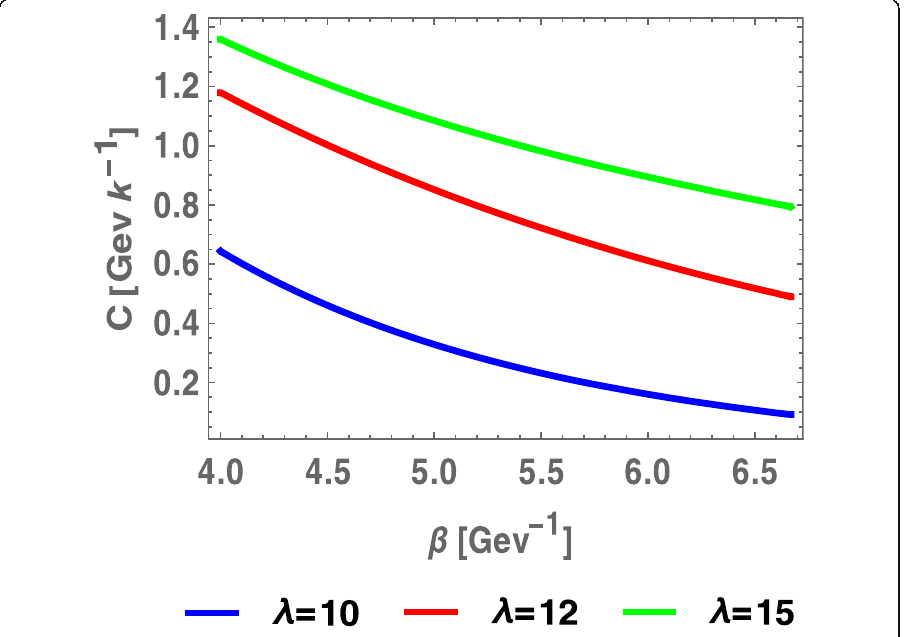
Fig. 5 Specific heat C is plotted against β different values of